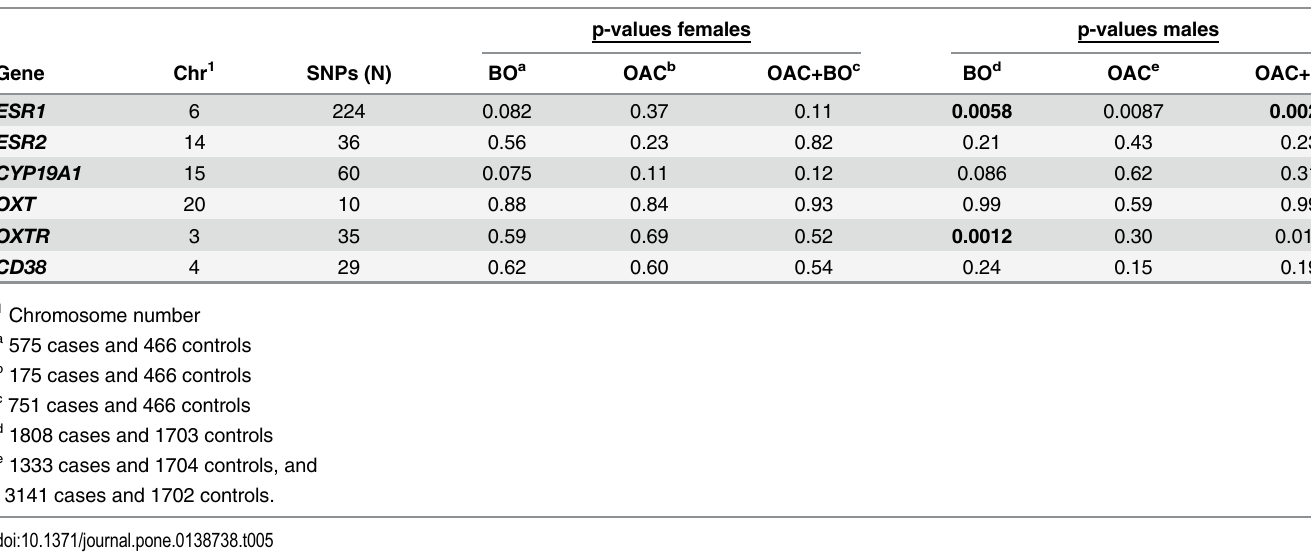
Table 5. Sex-specific gene-based analysis of top 90% single nucleotide polymorphisms (SNPs) in genes known to regulate oestrogen levels and oxytocin levels and risk of Barrett ’ s oesophagus (BO), oesophageal adenocarcinoma (OAC), and these conditions combined (OAC+BO). P-values in bold are statistically significant after correction for multiple